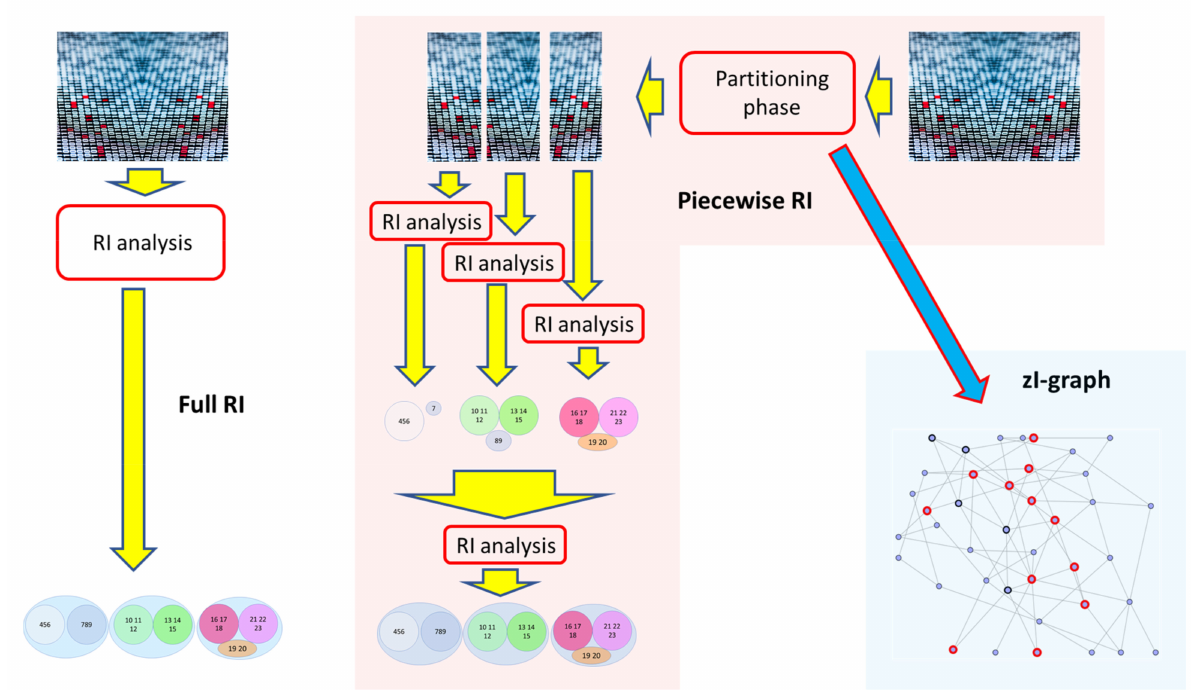
Figure 1. The three algorithms described in this paper. On the left, the original full RI method; in the center the piecewise RI; on the right the derived zI-graph method. The piecewise RI is based on a partitioning of the system under consideration. A complete analysis is made in each partition, and a final analysis is performed to allow the merging of parts of RSs mistakenly separated during the partitioning phase (in the example of the figure, the variable 7 present on the first partition which is eventually merged with variables 8 and 9 belonging to the second partition). In the case of the partitioning of the original system is based on binary relations (pairs of variables), it is possible to derive a representation of the organization of the system’s relationships in the form of a graph, an analysis which is important per se ( zI-graph